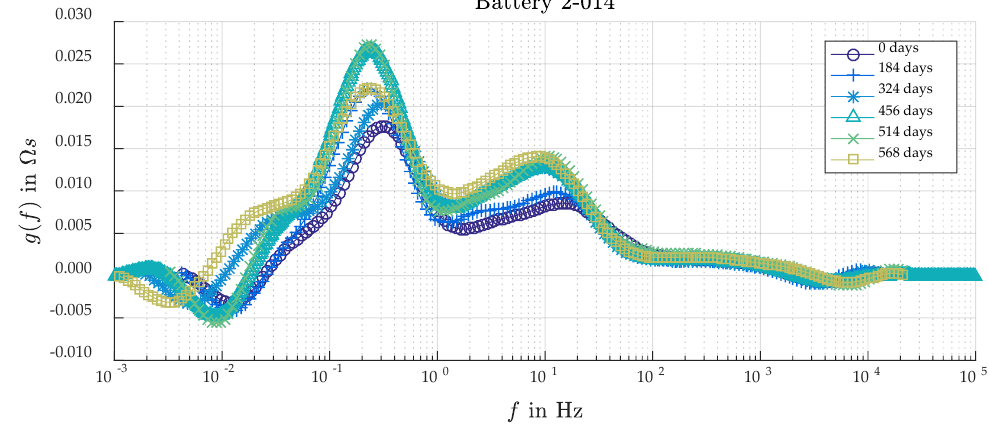
Figure 7. DRT analysis of the impedance spectra of battery 2-014 of string 2 for all check-up measurements.